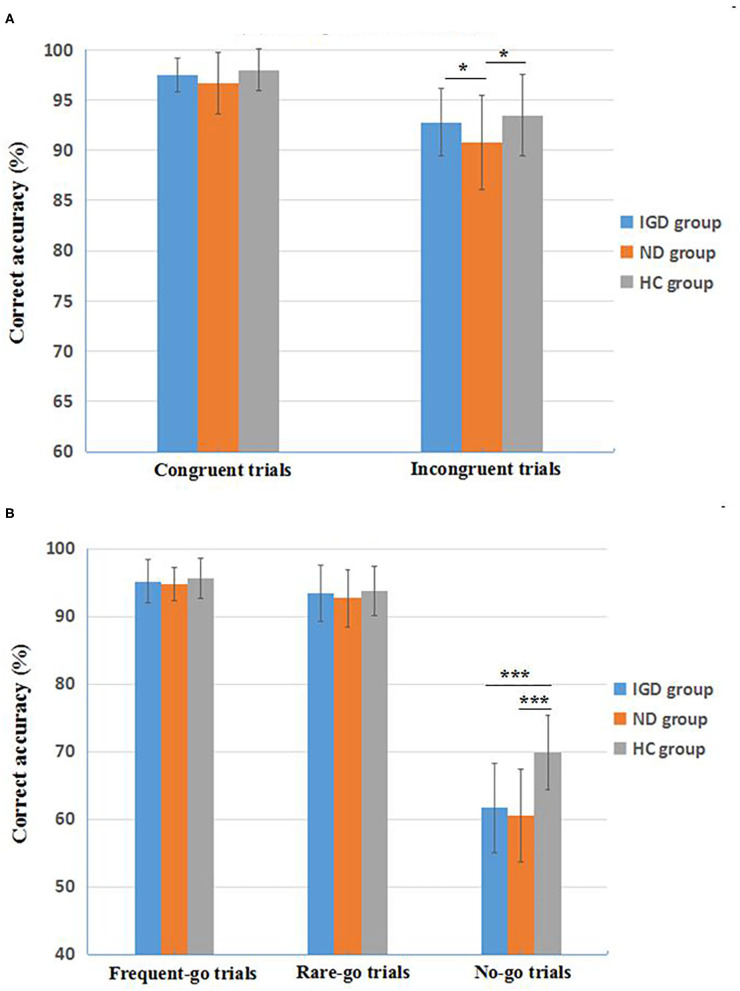
Inhibitory control performance on the Stroop Color-Word Task (A) and the revised Go/No Go Task (B) of the three groups. IGD, Internet Gaming Disorder; ND, Nicotine Dependence; HC, healthy controls. Data are presented as mean ± standard deviation (M ± SD). *p < 0.05, ***p < 0.001.